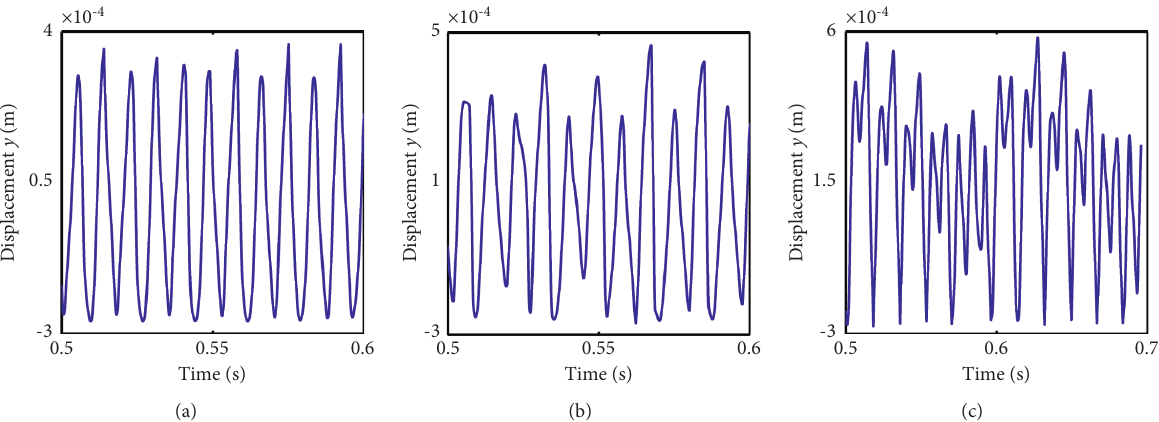
Figure 16: Vibration waveforms of the right journal with the change of the loose clearance. (a) δ � 0.1 × 10 –3 m, (b) δ � 0.27 × 10 –3 m, and (c) δ � 1 × 10 –3 m.